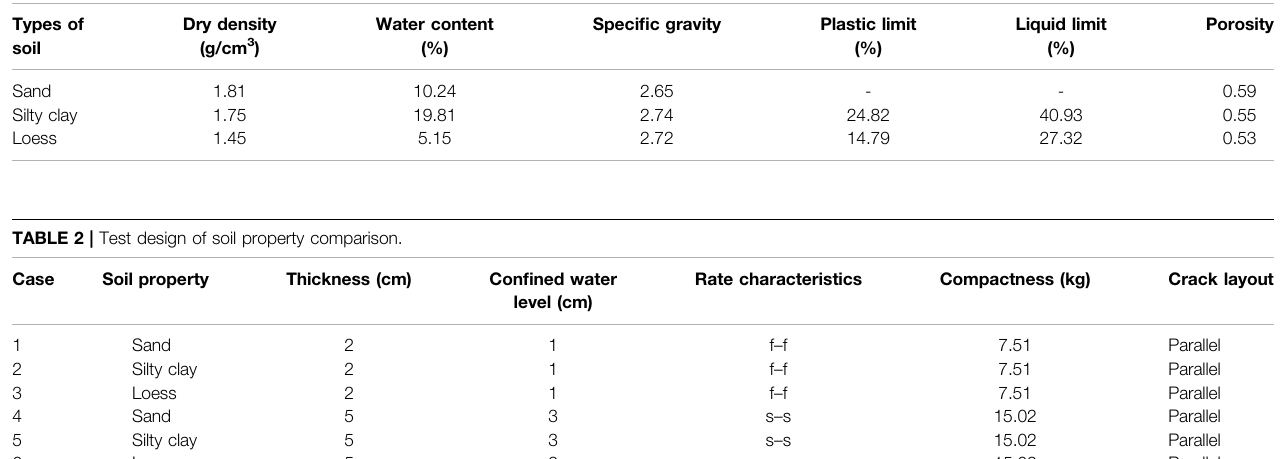
TABLE 1 | Basic physical indexes of three types of soils.